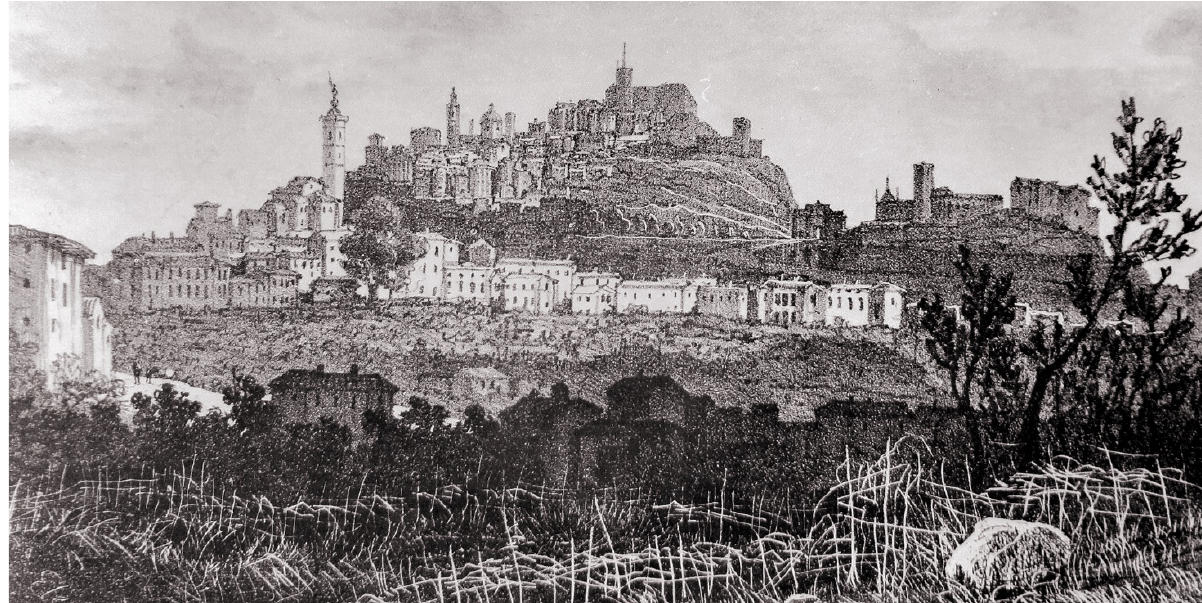
Figure 2. The complex of Sant'Agostino : eastern view from the lower city, 1852 (from the album "Natural and monumental curiosities of Lombardy drawing by Giuseppe Elena" printed by lithography of Corbetta,